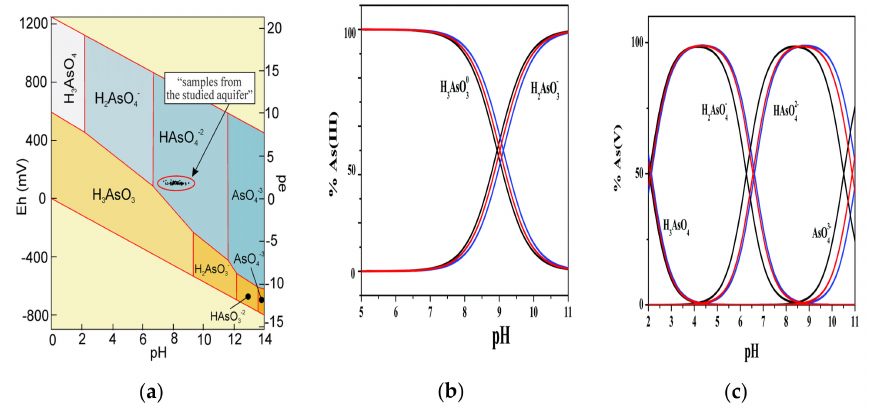
Figure 1. pH dependence of the aqueous speciation of As(III) and As(V) species. ( a ) redox potential (Eh)–pH diagram [9,17], ( b ) arsenite species and ( c ) arsenate species [16]. Operating conditions: 25 ◦ C and 1 bar total pressure. Reproduced with permission from Elsevier and